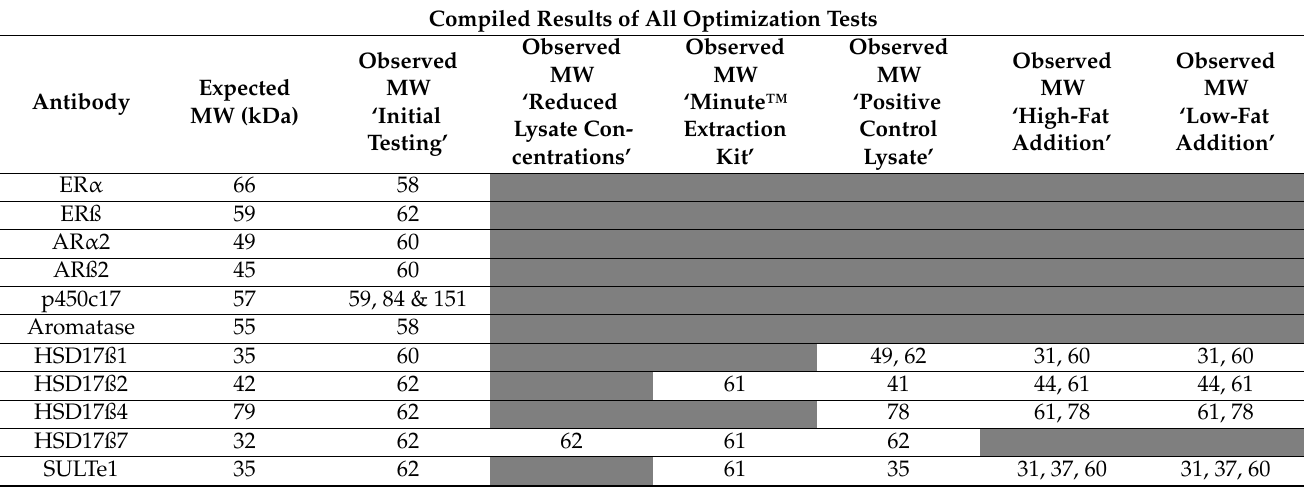
Table 2. Summary of expected and observed molecular weights for all 11 antibodies tested in each